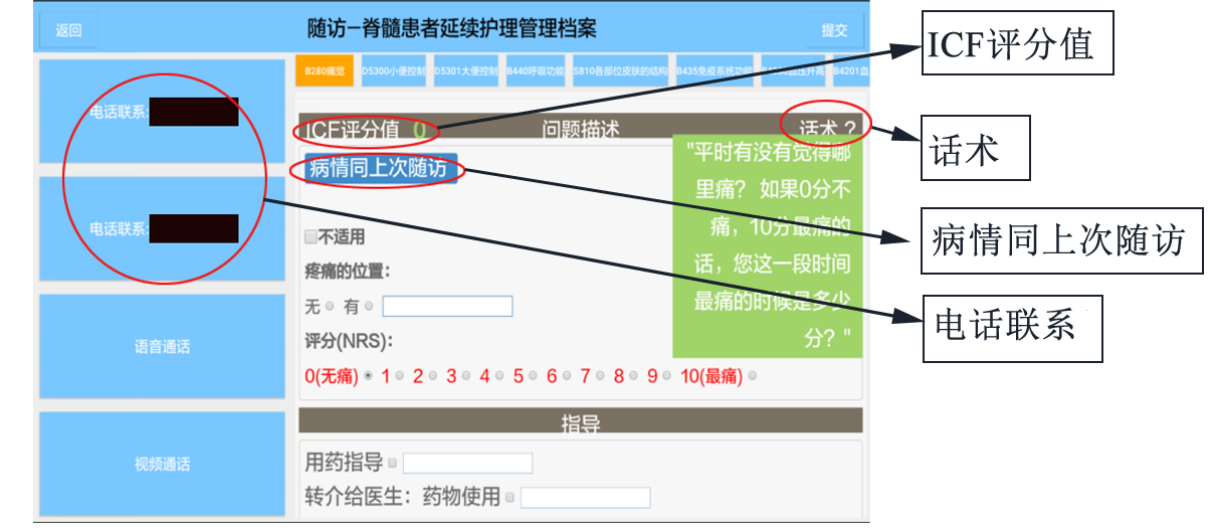
Figure 1. Remote assessment interface for the category of "b280 Sense of pain." ICF 评分值 means “ICF qualifiers.” After clicking, ICF qualifiers will be shown. 话术 means “verbal prompt.” After clicking, preset instructions will be shown. 病情同上次随访 means “The current condition is the same as the last follow-up.” 电话联系 means “Telephone.” The phone number of the patient is shown here. After clicking, the follow-up nurse can contact the patient by telephone. ICF: International Classification of Functioning, Disability, and Health.